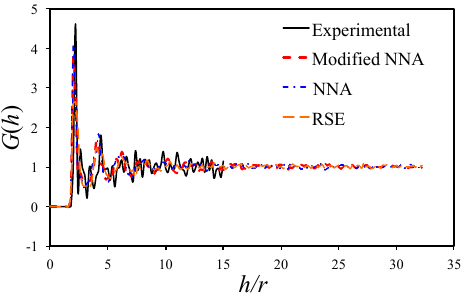
Figure 7. Radial distribution function for experimental characterized and numerical generated RVE.